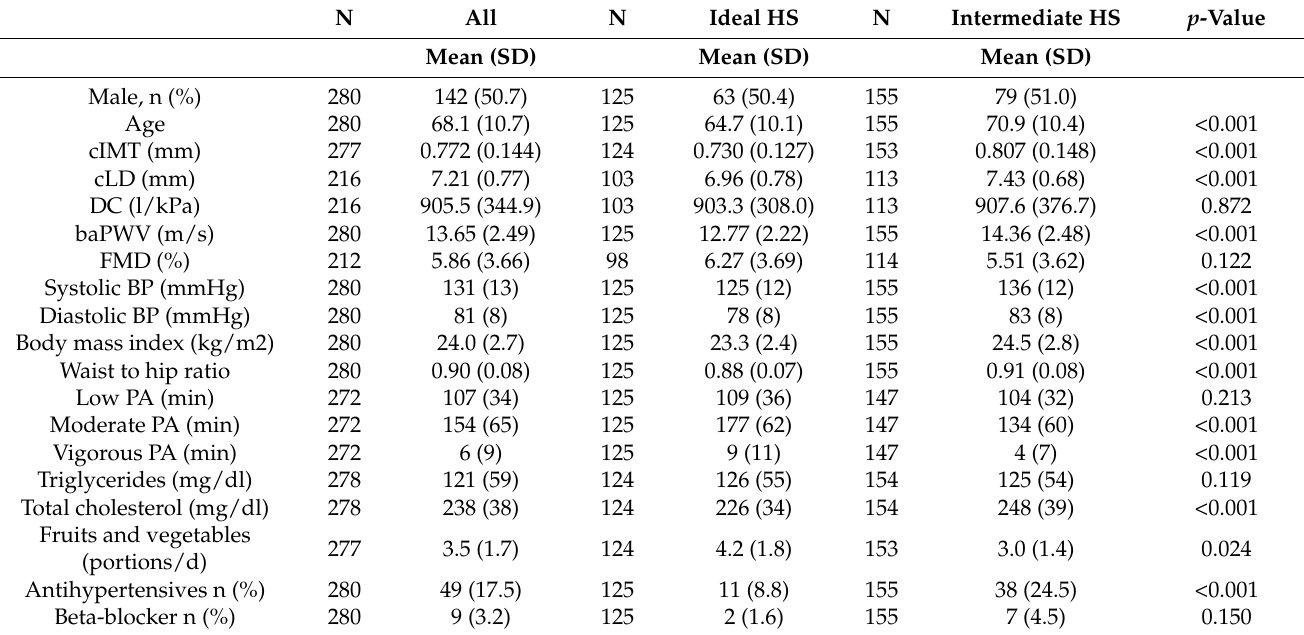
Table 1. Participants’ characteristics, by cardiovascular health score category. p -value indicates the difference between the ideal and intermediate health scores.